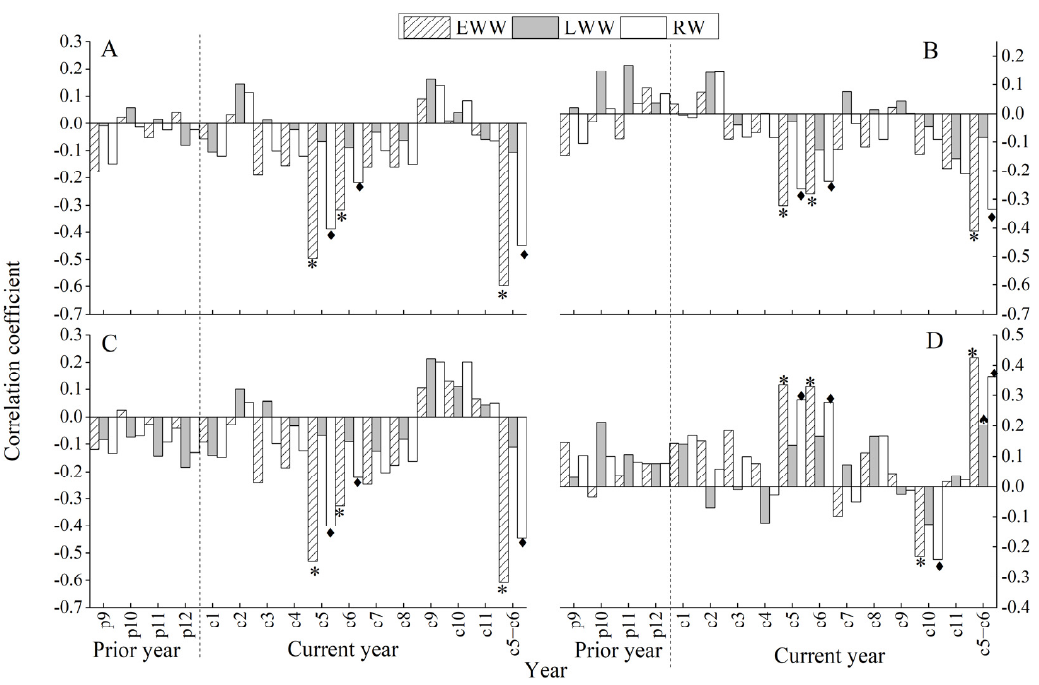
Figure 5. The correlation analyses between RES of EWW, LWW, RW and T ( A ), Tmin ( B ), Tmax ( C ), P ( D ) of the Tongbai meteorological station. *, and ◆ all stand for p < 0.05.